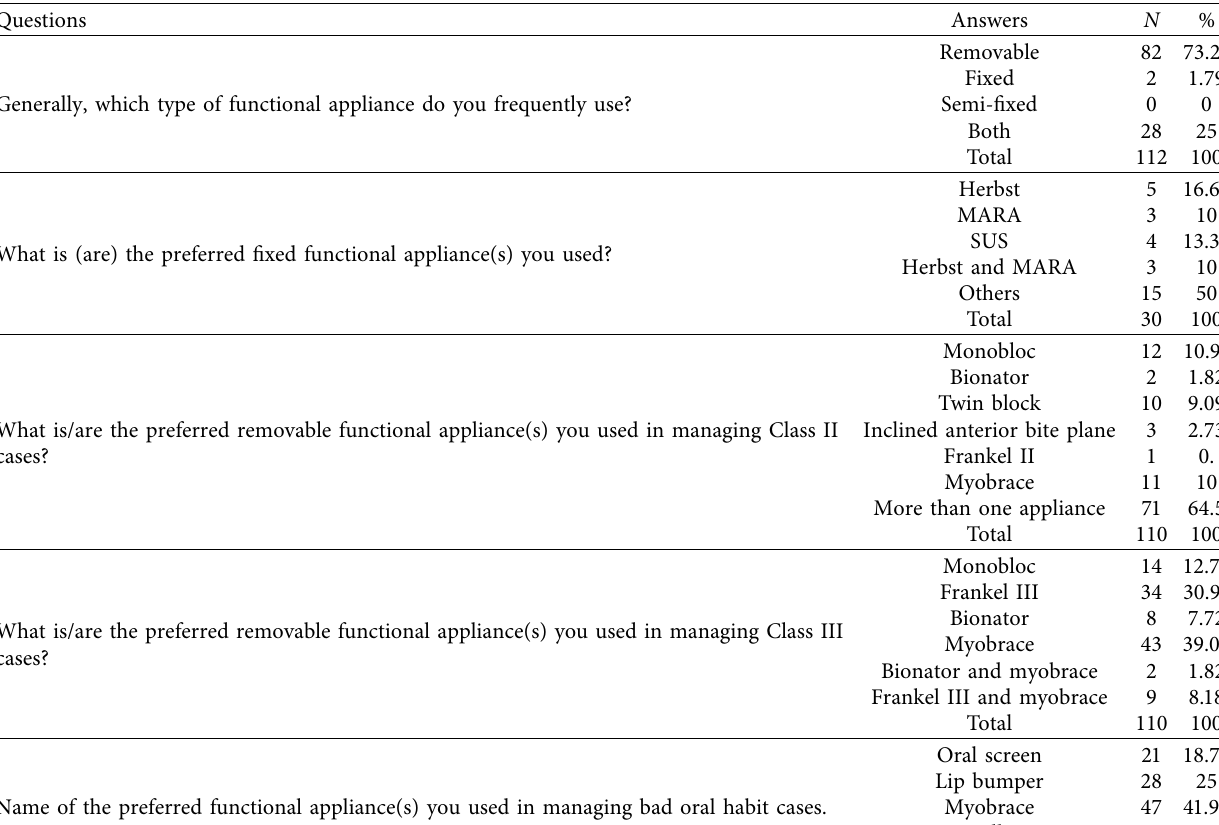
Table 3: Appliance preference, diagnosis, wearing, and retention